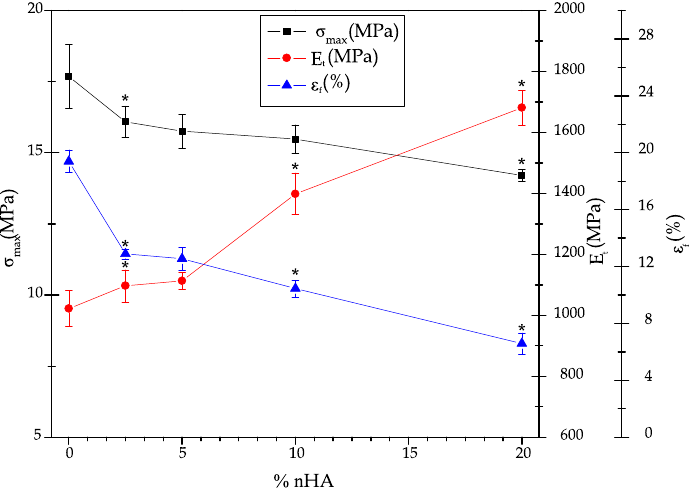
Figure 1. Evolution of the maximum tensile stress ( σ max ), tensile modulus (E t ), elongation at break ( ε b ) in the injection-molded parts of poly(3-hydroxybutyrate- co -3-hydroxyhexanoate) [P(3HB- co -3HHx)] with the content of hydroxyapatite nanoparticles (nHAs). * Indicates a significant difference compared with the previous sample ( p < 0.05)